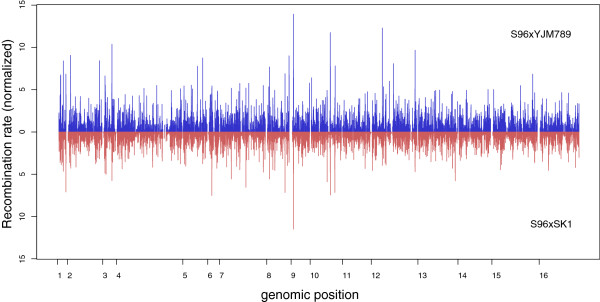
Genome-wide recombination rate of S. cerevisiae segregants. Recombination rate (normalized by the mean) of 184 segregants of an S96xYJM789 cross [17] are plotted in blue (top) and recombination rate from 720 segregants of an S96xSK1 cross (this study) are plotted in red (bottom) using a 2 kb window.